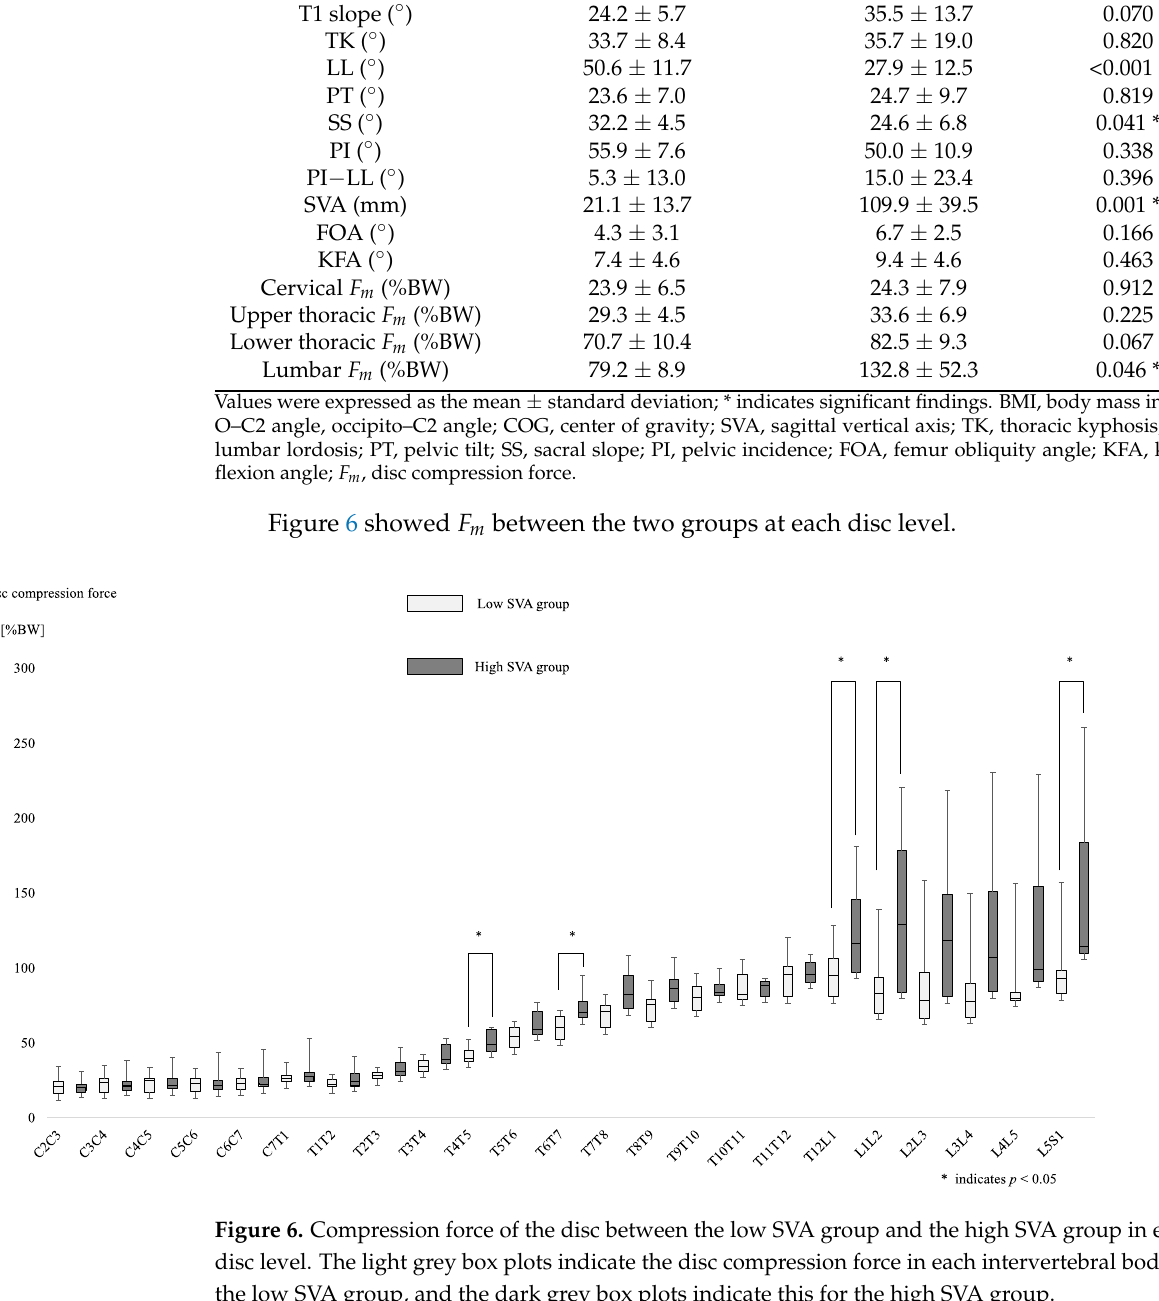
Figure 6. Compression force of the disc between the low SVA group and the high SVA group in each disc level. The light grey box plots indicate the disc compression force in each intervertebral body in the low SVA group, and the dark grey box plots indicate this for the high SVA group. F m was higher in the high SVA group at the T4/5 ( p = 0.008), T6/7 ( p = 0.033), T12/L1 ( p = 0.039), L1/2 ( p = 0.044), and L5/S1 ( p = 0.039) levels. The peak F m was in T12/L1 (88.4 ± 12.4) for the low SVA group and in L5/S1 (150.1 ± 55.9) for the high SVA